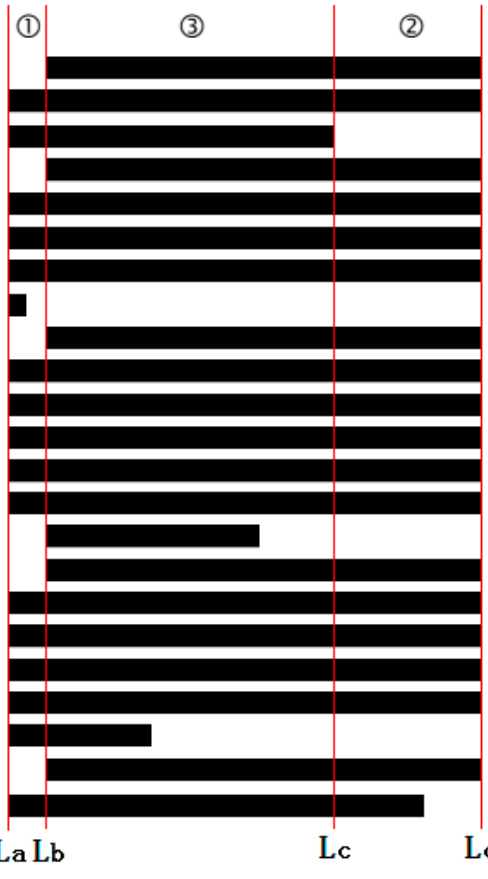
Figure 7. Page of a document divided into three areas.